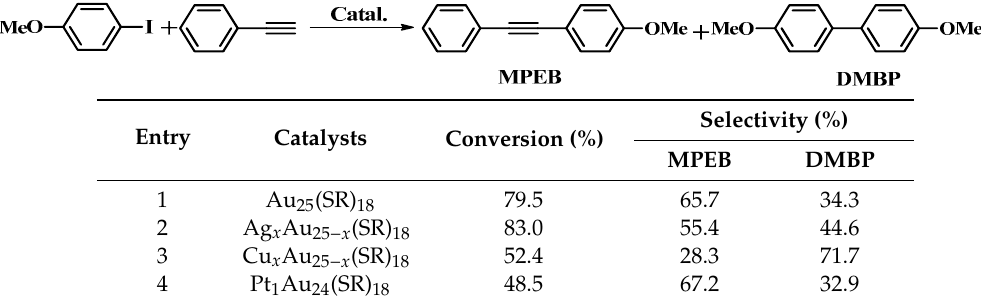
Table 5. Catalytic performance of TiO 2 -supported M x Au 25 – x (SR) 18 catalysts in the C – C coupling reaction between MeOC 6 H 4 I and PA. Reaction conditions: 100 mg catalyst, 1 wt % M x Au 25 – x (SR) 18